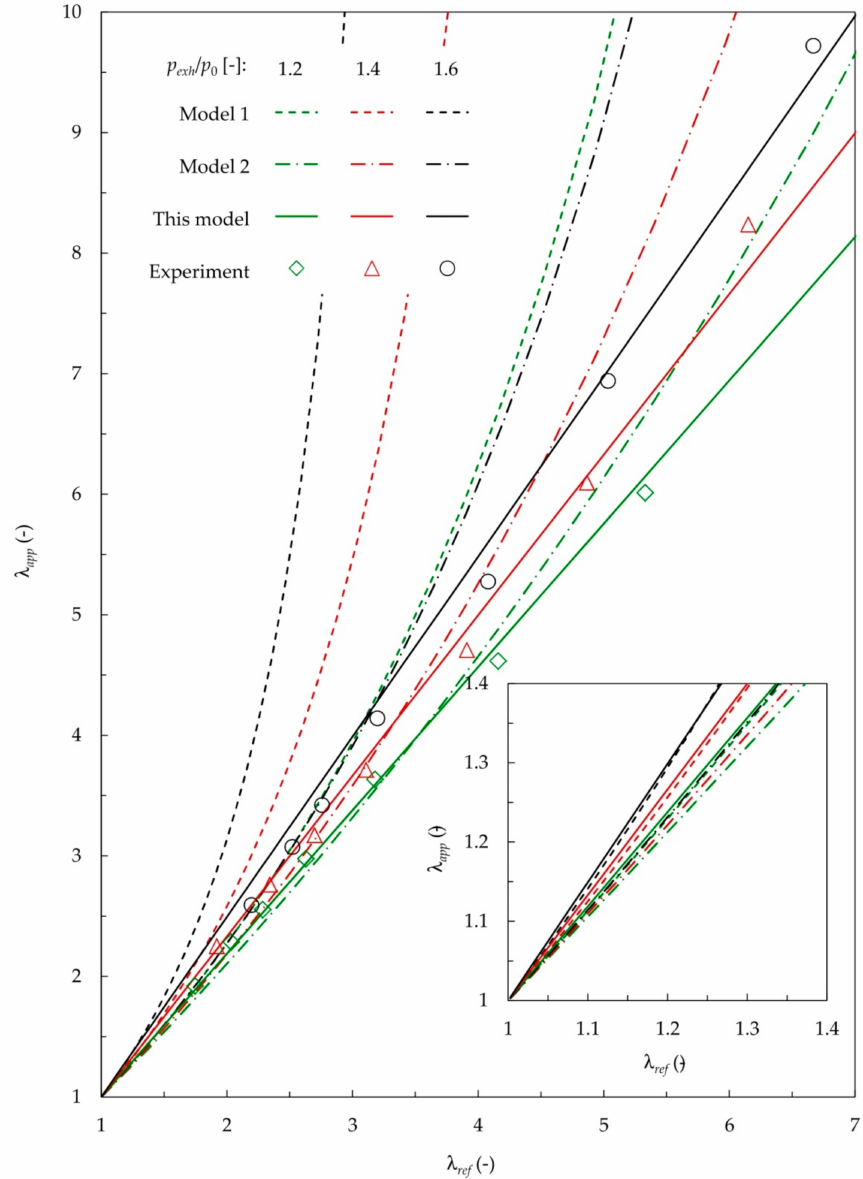
Figure 7. Comparison of λ app calculated using available models (Model 1—Equation (5) [17], Model 2—Equation (4) [25]) and the model elaborated in this study with experimental verification